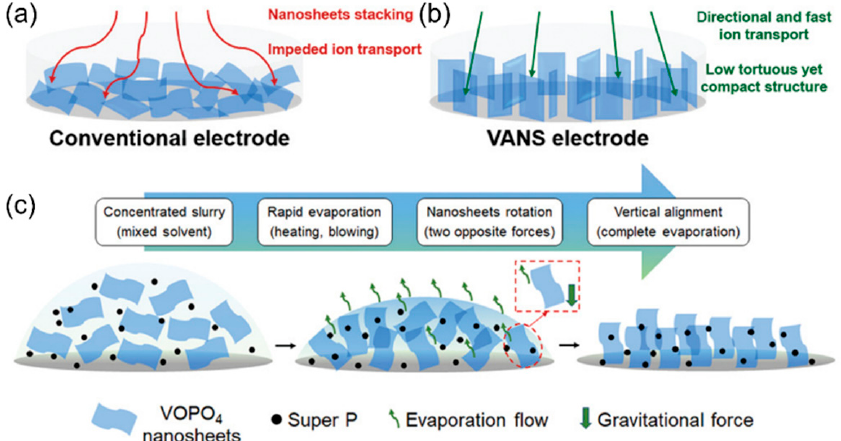
Figure 6. Comparison of the ( a ) conventional electrode and ( b ) VANS electrode with vertical align- ment. ( c ) The evaporation-induced method of making vertically aligned electrodes. Reproduced with permission from ref. [94]. Copyright 2020, Wiley-VCH.